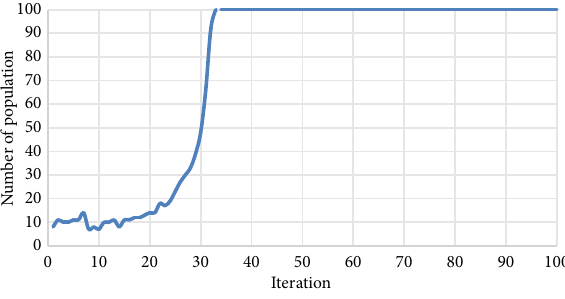
Fig. 19. The population number in the first front for the third model